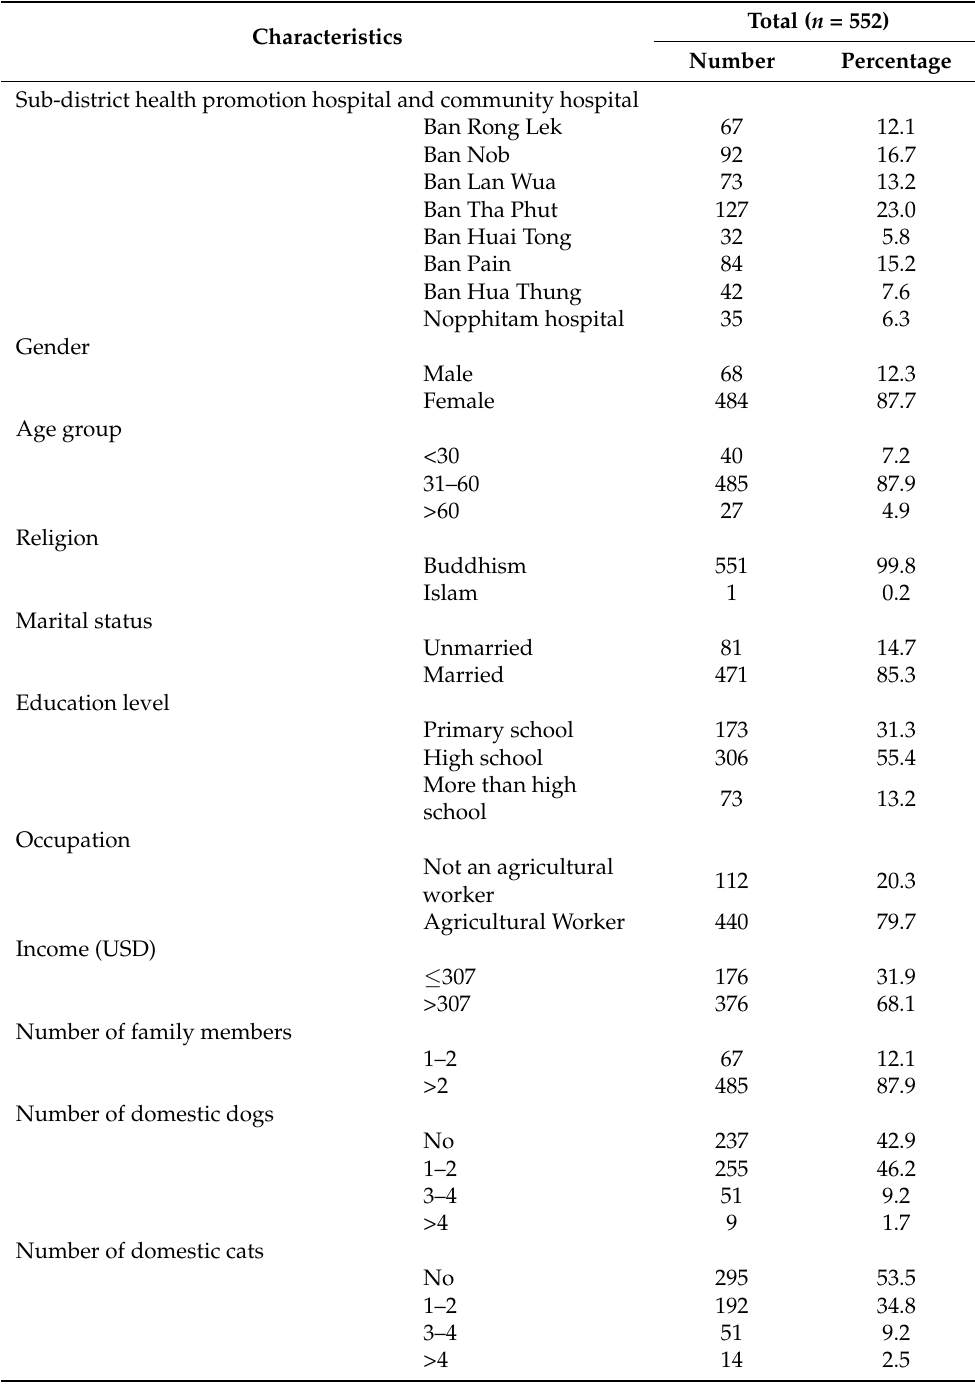
Table 1. Sociodemographic characteristics of village health volunteers enrolled in the study.